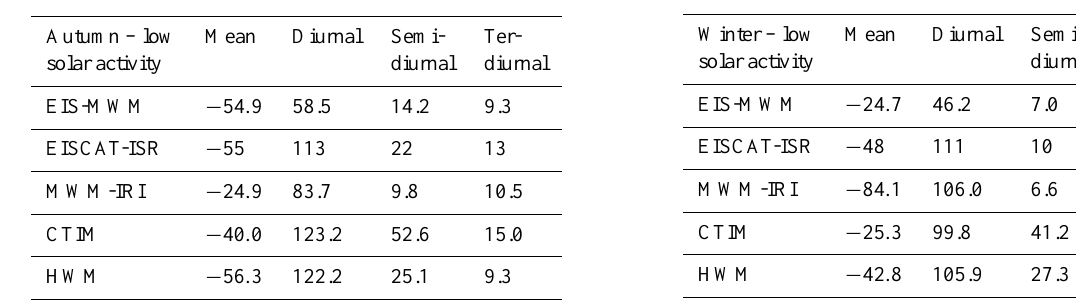
Table 4. As for Table 1 but for winter season, low solar